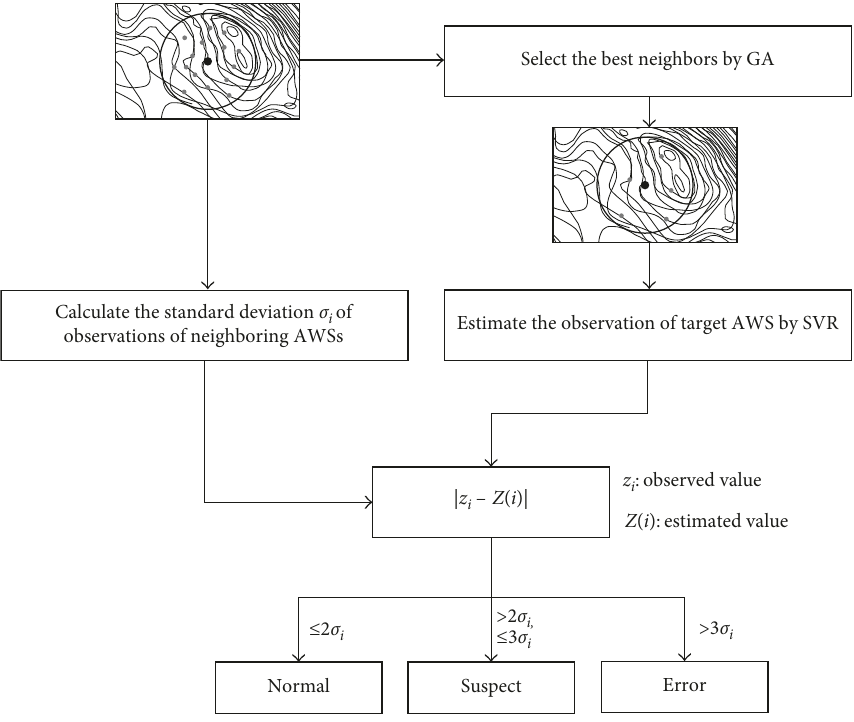
Figure 5: The proposed spatial quality control Table 7: Accuracy of estimates for each similarity measure. Table 6: Accuracy of estimates according to wind direction rep- resentation (RMSE).